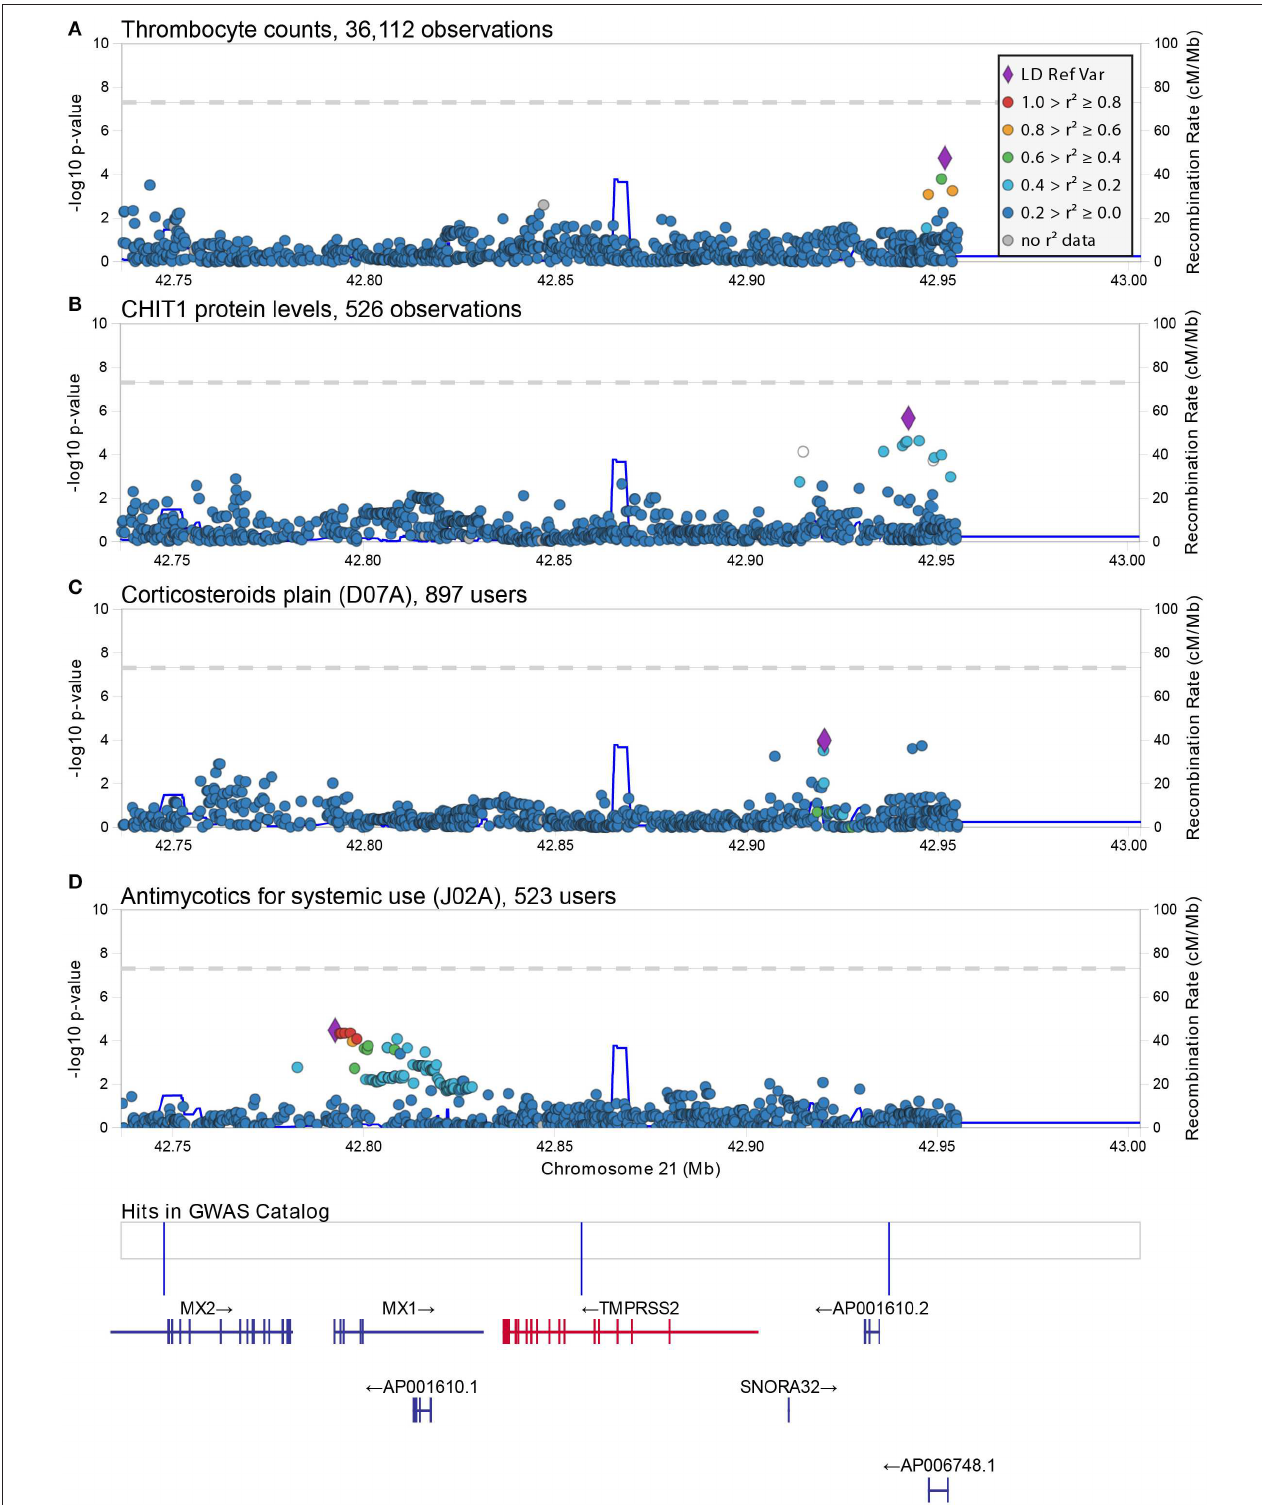
FIGURE 2 | Regional associations plot at the TMPRSS2 locus. Graphical representation of the association results at the TMPRSS2 locus for the SNP-trait associations reported in Table 1 (A,B) and Table 2 (C,D) . In each panel, each dot represents a genetic variant and shown is the association strength (expressed